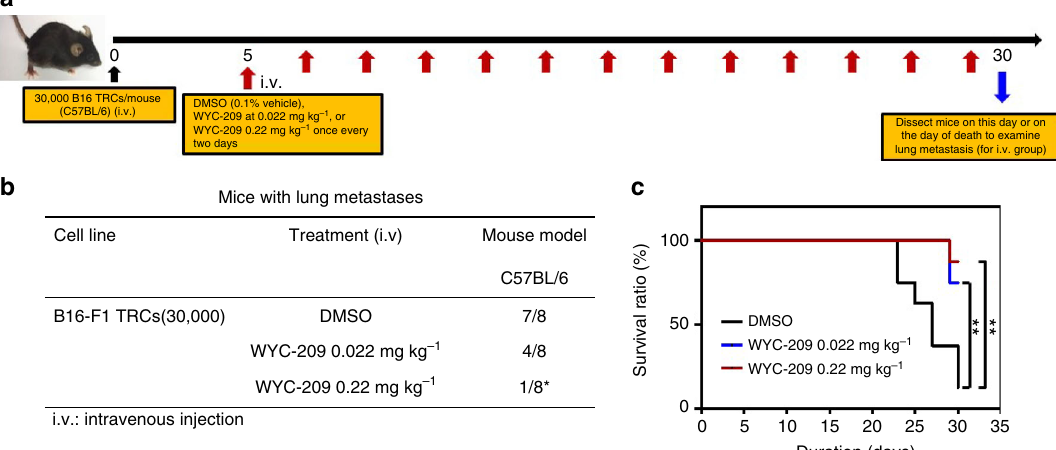
Fig. 5 WYC-209 inhibits tumor metastasis in vivo. a Schematic of the experimental protocol; i.v., intravenous injection. Control B16-F1 cells were cultured in 90-Pa fi brin gels for 5 days to form TRCs. TRCs were isolated from gels and injected intravenously via tail veins into wild-type immune-competent syngeneic C57BL/6 mice at 30,000 cells per mouse. Three groups of mice were treated in this experiment, 8 mice each group. DMSO group: 8 mice were injected with TRCs for 5 days and then were treated with DMSO (0.1%, vehicle) every 2 days via intravenous injection. WYC-209 0.022mg kg − 1 : 8 mice were injected with TRCs for 5 days then treated with WYC-209 0.022 mg kg − 1 every 2 days by intravenous injection. WYC-209 0.22 mg kg − 1 : 8 mice were injected with TRCs for 5 days and then were treated with WYC-209 0.22 mg kg − 1 every 2 days by intravenous injection. Mice were dissected on day 30 or on the day of death to examine signs of lung metastases. b Lung metastasis frequency of B16-F1 TRCs after treated with WYC-209. * P < 0.05 with Fisher ’ s exact test. c Survival ratio of C57BL/6 mice transplanted with TRCs treated with WYC-209 or DMSO in protocol ( a ). Statistical analyses of survival ratio in c were performed by Mantel – Cox test ( ** P < 0.01 compared to DMSO-treated